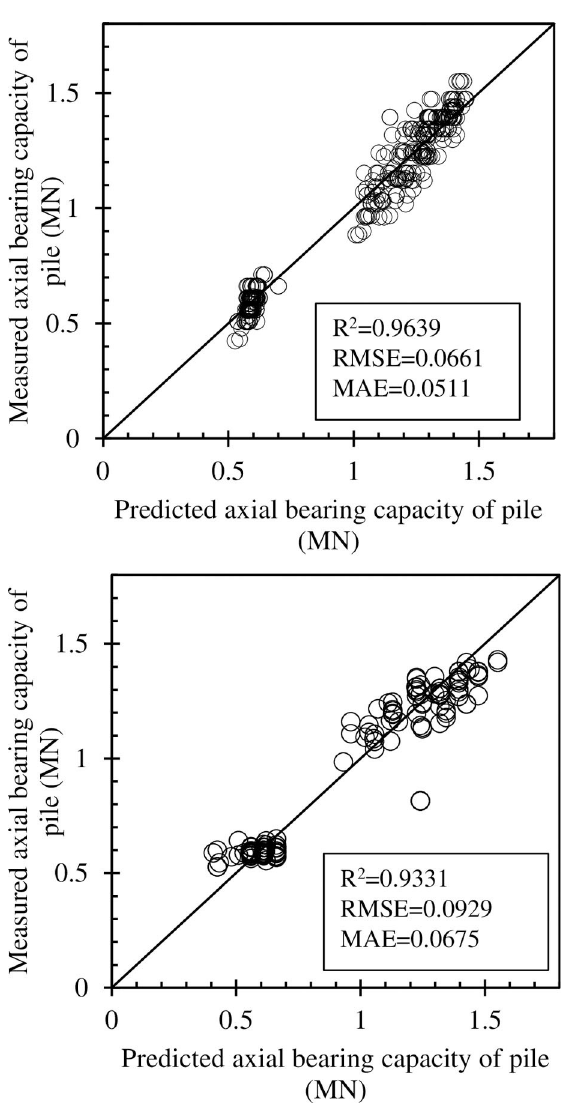
Fig 11. Regression graphs for the case of the best parameters of RF-GA model (a) training dataset; and (b) testing dataset.